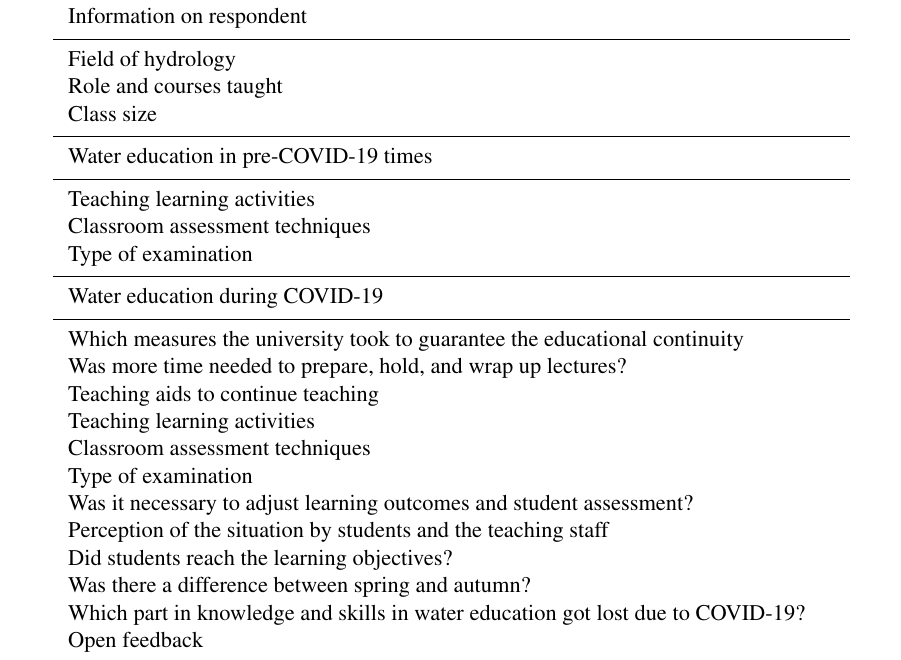
Table 1. The different sections of the